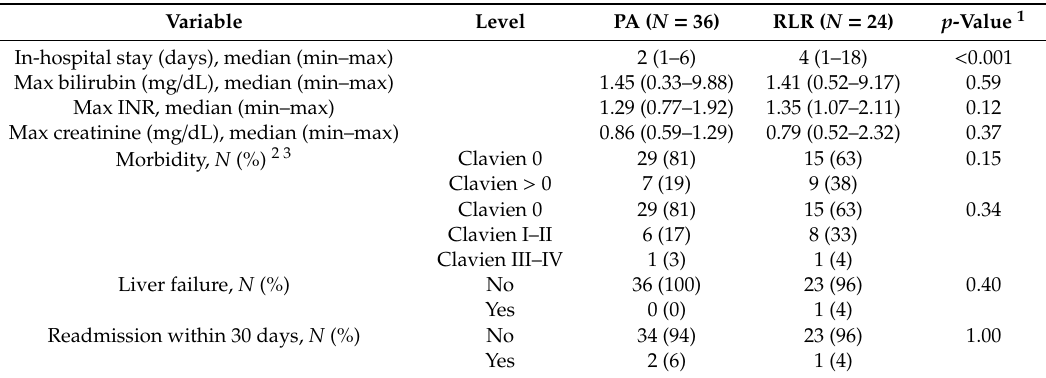
Table 3. Outcomes ( N = 60).